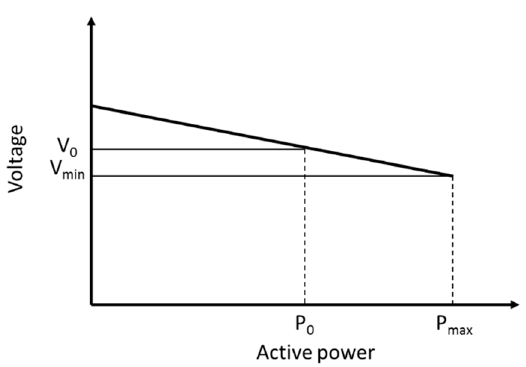
Figure 8. Voltage ‐ active power (V ‐ P) droop characteristic in the DC microgrid.